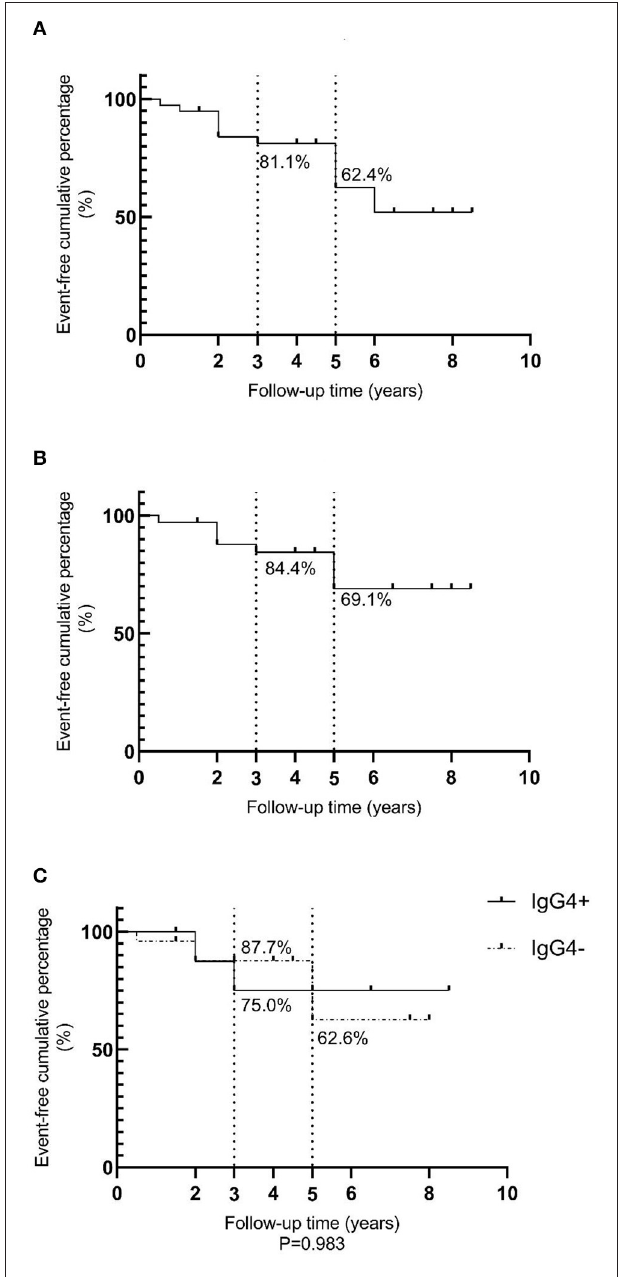
FIGURE 3 | Event-free survival analysis for lymphomas. (A) A total event-free survival analysis of 39 lymphomas; (B) A total event-free survival analysis of 34 MALT lymphomas; (C) Comparative analysis of event-free survival in nine IgG4 + MALT lymphomas and 25 IgG4-MALT lymphomas, P = 0.983.